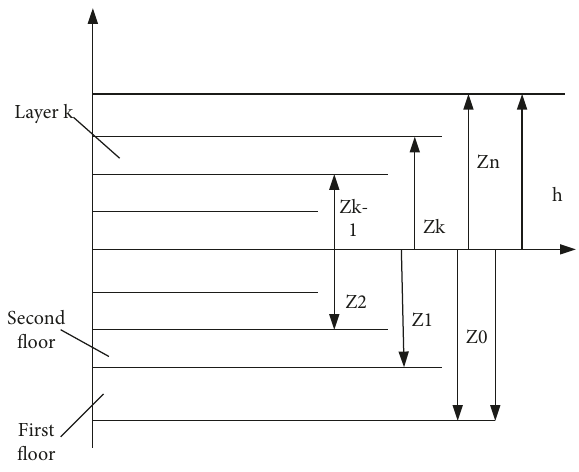
Figure 5: Sectional view of laminated composite.